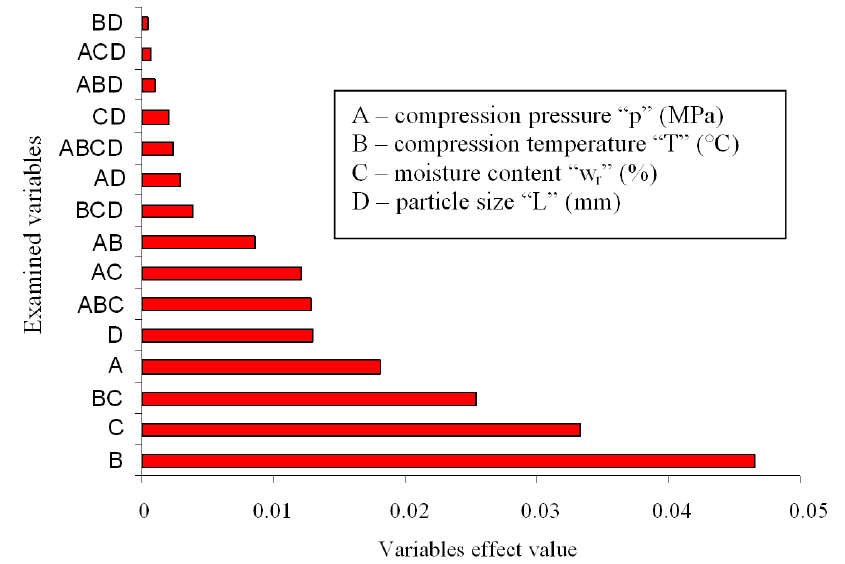
Figure 1. Paret’s effect diagram for pine sawdust densification